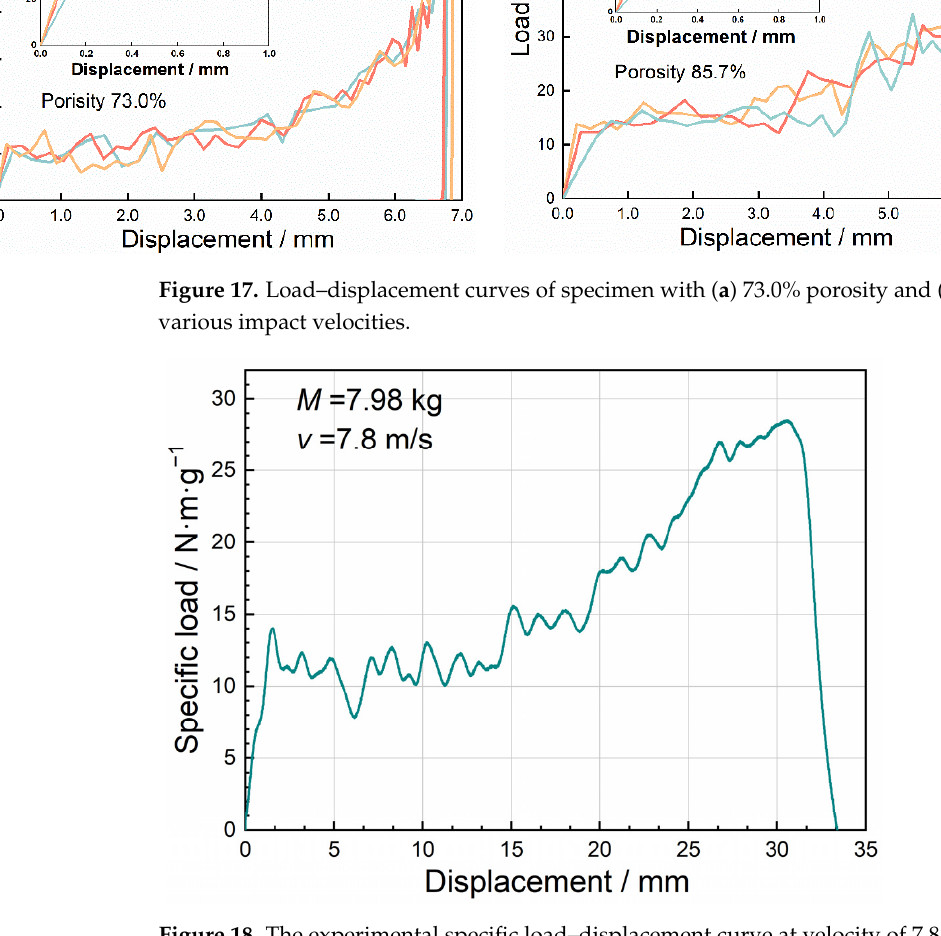
Figure 18. The experimental specific load–displacement curve at velocity of 7.8 m/s. Table 2. Impact properties of closed-cell Al foam specimens.